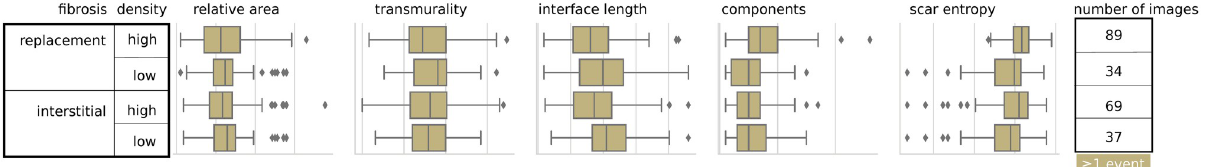
Fig 4. Distribution of scar feature values for various microstructure types. Microstructure types are classified as interstitial or replacement, and high (max density 0.8-1.0) or low (max density 0.4-0.6) density. Each data point represents an image whose models experienced at least one event (reentry or block) for a particular microstructure